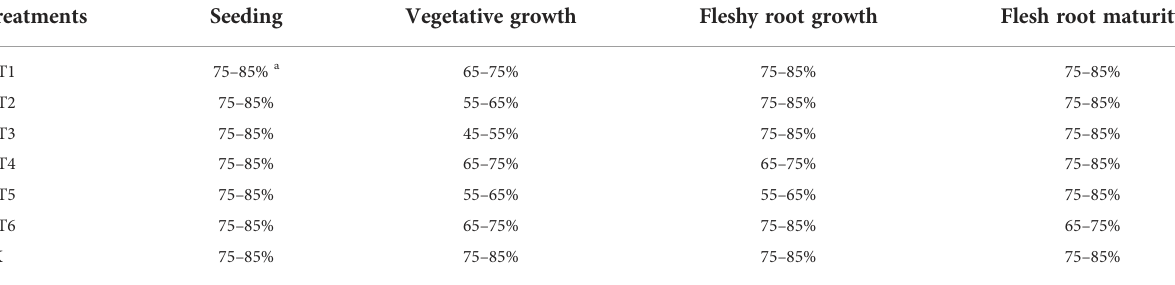
TABLE 1 Experimental design.